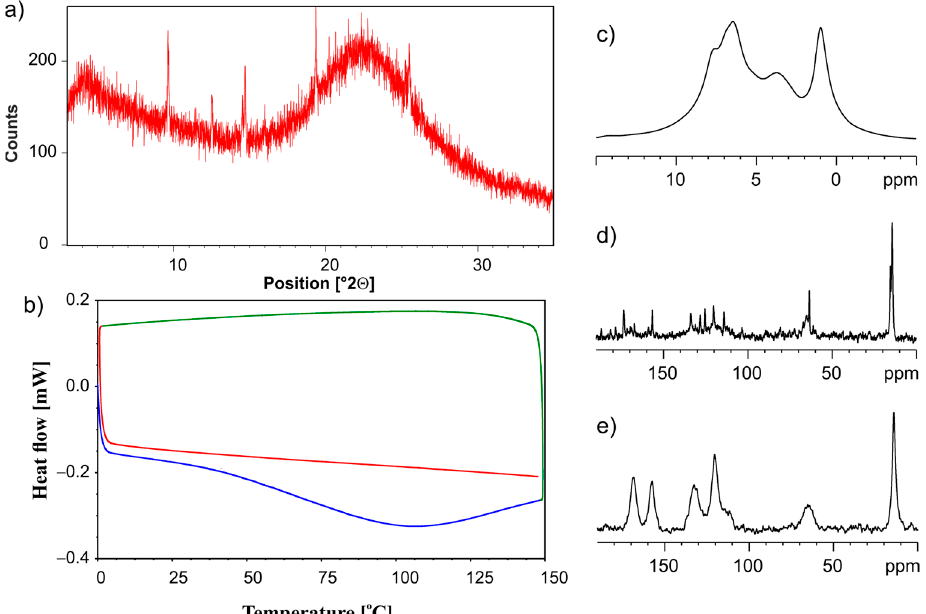
Figure 7. ( a ) PXRD recorded on a PANalytical 3 kW system in Bragg–Brentano geometry and with a Cu K α ( λ = 1.5425 Å) source, ( b ) the DSC measurement. The fi rst heating run from 0 °C to 150 °C (blue line), then a cooling run from 150 °C to 0 °C (green line), followed by a second heating run from 0 °C to 150 °C (red line), ( c ) 1 H MAS, ( d ) 13 C CP MAS, and ( e ) 13 C SPE MAS NMR measurements recorded with a spinning rate of 12 kHz for the physical mixture of ET/SiO 2(hydr) ground in a ball mill.